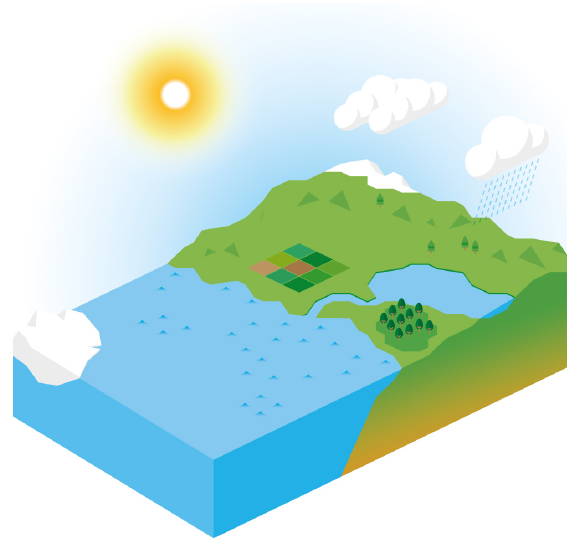
Figure 1. Components of the European Centre for Medium-Range Weather Forecasts’ (ECMWF’s) Integrated Forecasting System (IFS) Earth system. Along with the atmosphere, there are the ocean, wave, sea ice, land surface and lake